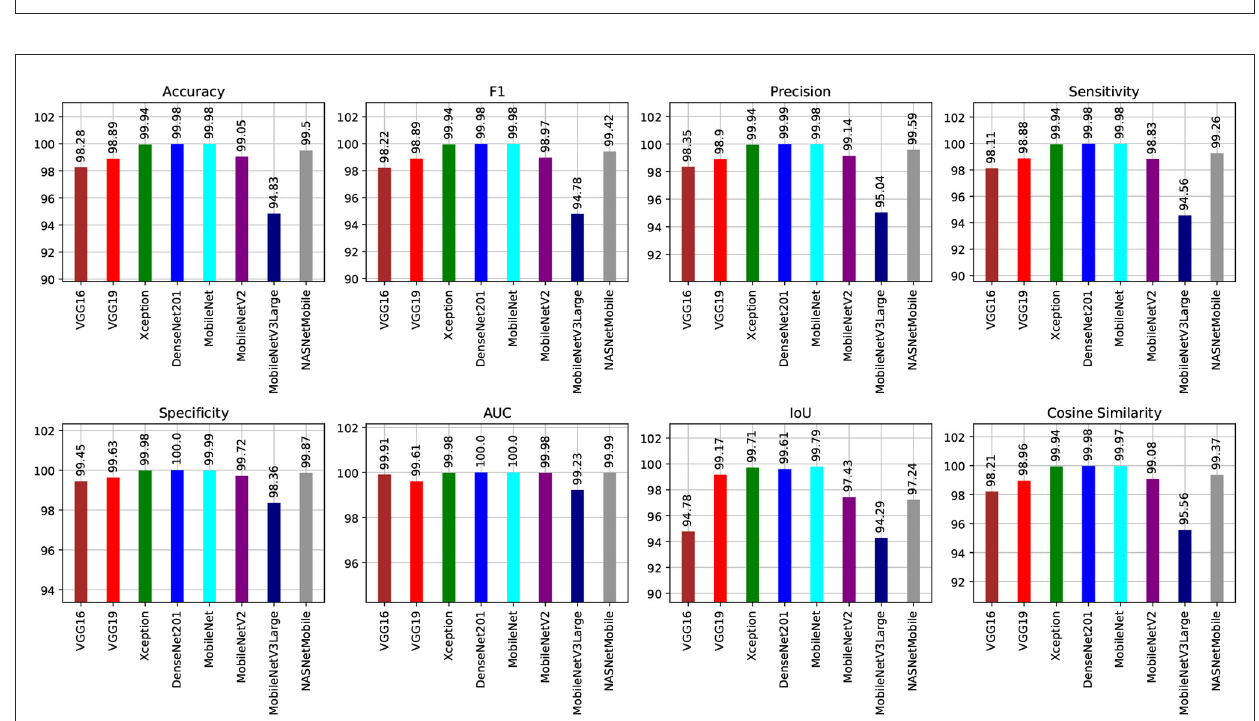
FIGURE8 Summarization of the learning and optimization experiments related to the Four-classes dataset.